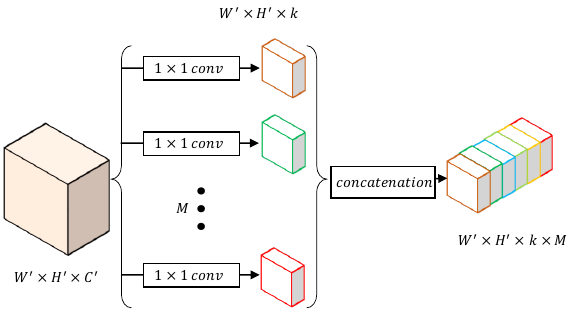
Figure 5. Construction of the class-wise transition (CT) block by class-wise convolution.